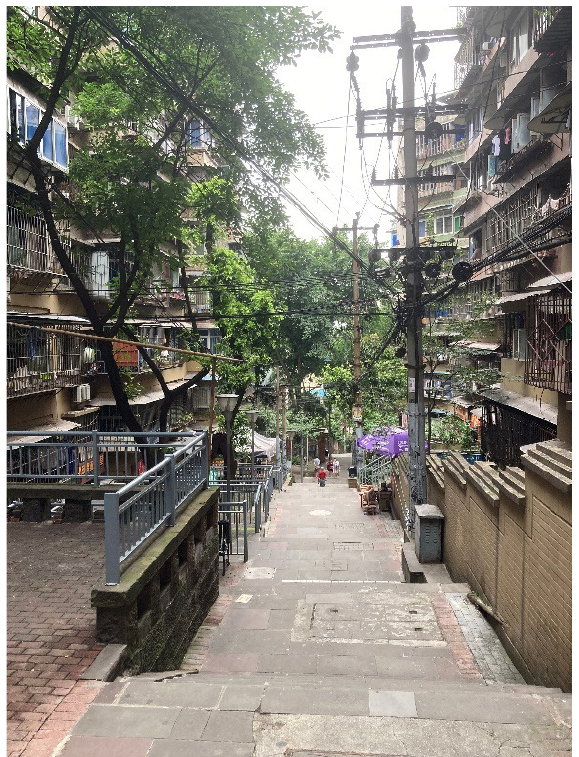
Figure 8. An alley in Chongqing with stairs and some res‐ idential buildings beside it, now part of the third path of the Mountainous City Footpath.